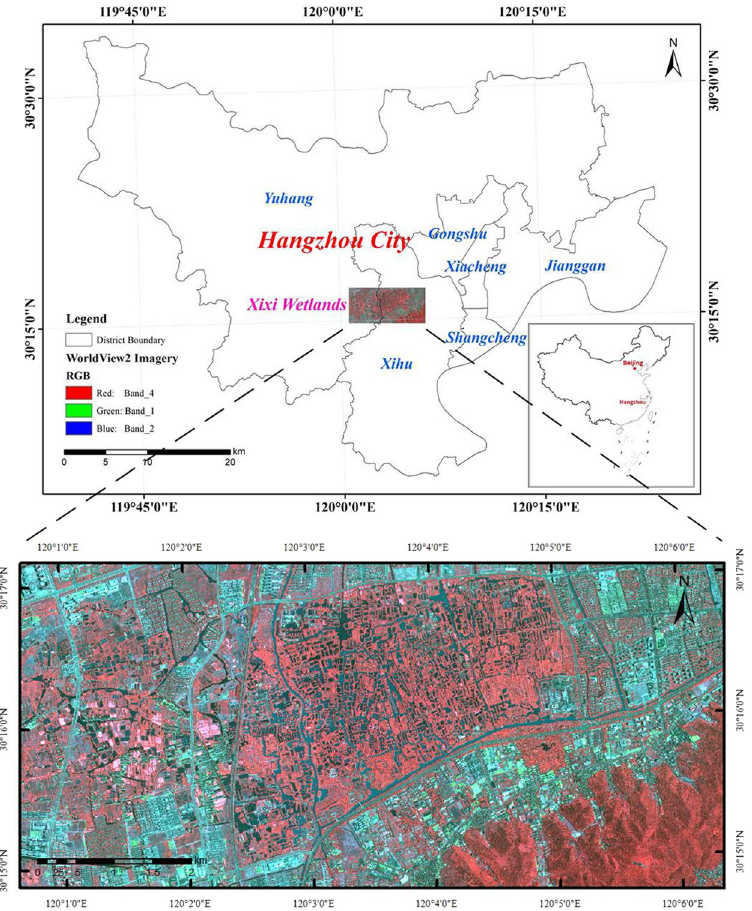
Figure 1. Location of the study area. The aerial photograph was produced by high spatial resolution satellite imagery: WorldView2 data on May 17, 2012. The data were acquired from Siwei Worldview Technology (Beijing) Co., Ltd. For more information about Siwei Worldview Technology (Beijing) Co., Ltd., please visit www.siweidg.com. This figure was created using ArcGIS ® software by ESRI. ArcGIS 10.2 and ArcMap 10.2, which are the intellectual property of ESRI and are used here in under license. For more information about ESRI software, please visit